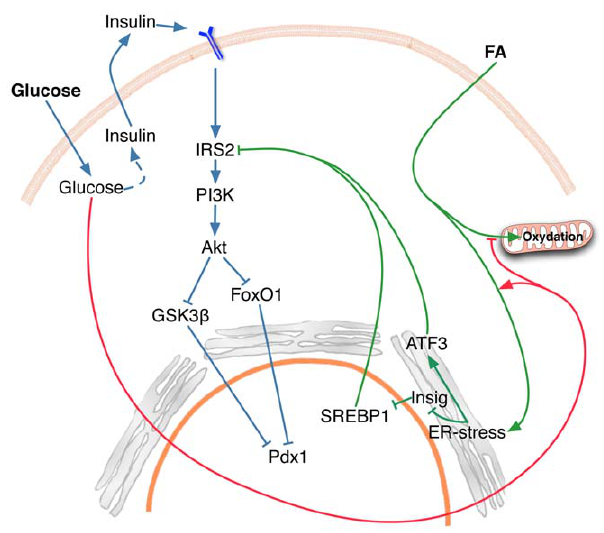
Figure 8. Working diagram illustrating some of the key steps involved in ‘‘glucolipotoxicity’’ of b -cells. High glucose and FFA together result in a vicious negative cycle that ultimately promotes b - cell death. As suggested by our findings, high glucose addition to FFA treated b -cells results in much more activation of SREBP1 than glucose alone. SREBP1 enhances ACC expression with generation of malonyl- CoA which impairs FFA oxidation. This in turn leads to augmented ER stress with further activation of ER-localized SREBP1 as a result of degradation of the anchoring protein Insig1. The excess non- metabolized FFA due to more impairment of FFA oxidation would partition in ER membranes compounding ER stress. In addition to SREBP1, ER stress activates ATF3. Both nuclear SREBP1 and ATF3 result in inhibition of IRS2, with concomitant impairment of insulin signaling, activation of Gsk3 b and reduction of Pdx1 leading to